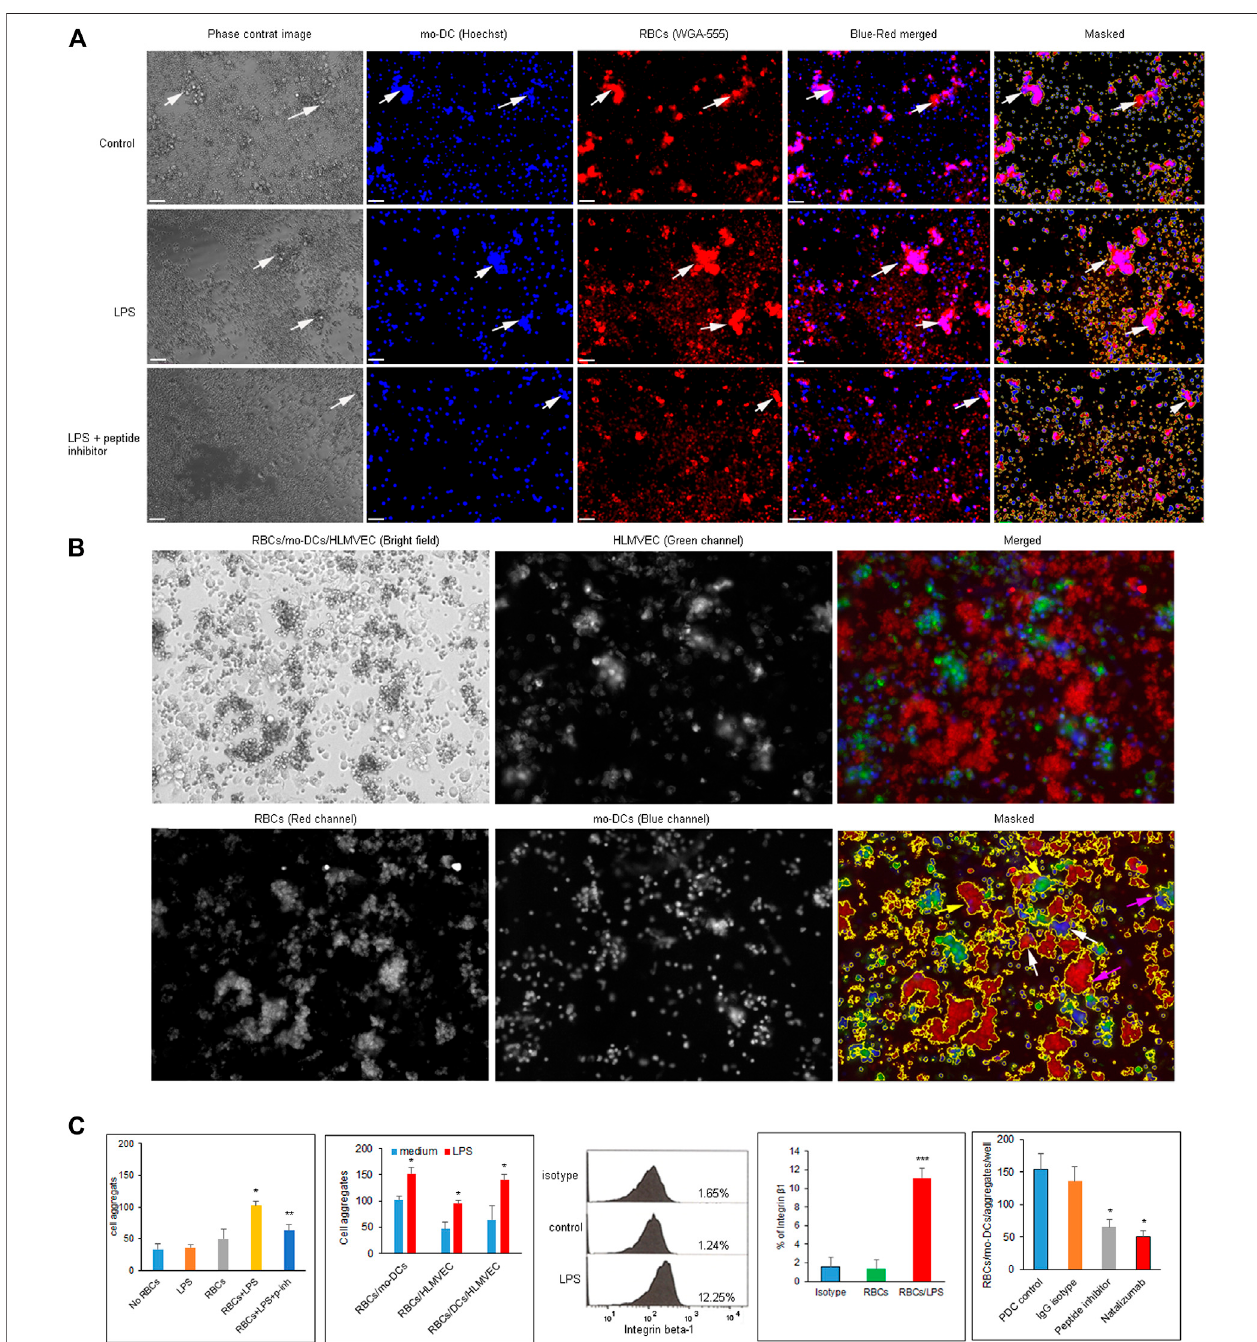
FIGURE 2 | (A) Images of RBCs/mo-DCs aggregates captured by Keyence fl uorescence microscope. RBCs and mo-DCs were pre-labeled with WGA-555 and Hoechstdye,respectively.Toppanelsshowmediumcontrol;middlepanelsshowLPStreatedRBCsgroup(LPS50 μ g/mlfor24 h);bottompanelsshowtheRBCs/mo- DCsgroupwithRBCpretreatedwith10 µMofthecyclicpeptideinhibitorofintegrin α 4 β 1.Whitearrowspointed RBCs/mo-DCsaggregates. (B) Theimagingstrategyto distinguish cell aggregation with the corresponding three cell types in cell suspension. RBCs, mo-DCs, and HLMVEC were pre-labeled with WGA-555, Hoechst dye and WGA-488 respectively. Accordingly, aggregates were de fi ned as RBCs/mo-DCs (white arrows), RBCs/HLMEC (yellow arrows), and RBCs/mo-DCs/HLMEC (pink arrows). (C) Quanti fi cation of cell aggregation calculated by imaging analysis software (left two panels). Several controls were used to access the ability of cell aggregation as indicated. Flow cytometric analysis of the integrin β 1 expression on RBCs (middle panel). Integrin β 1 on RBCs treated by LPS increased signi fi cantly compared to untreated control (graph bar panel, right side of fl ow cytometry picture). The α 4 β 1 peptide inhibitor (10 µM) or Natalizmab (10 μ g/ml) blocked cell-cell aggregation of RBCs/mo-DCs in a concentration-dependent manner while peptide control or Methylprednisolone alone had no effect on cell aggregation (Bottom right panel). All data were representative of mean ± SD, with at least three biological replicates. * p < 0.05, *** p < 0.001.